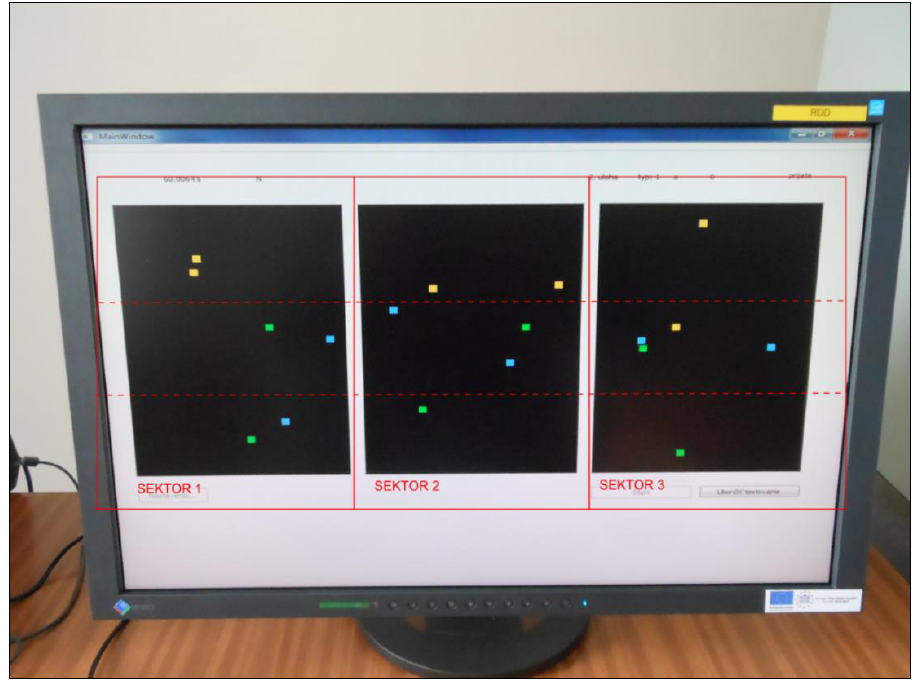
Figure 8. The display unit of the device for measuring the reaction time and the relative error rate in multitasking tasks.